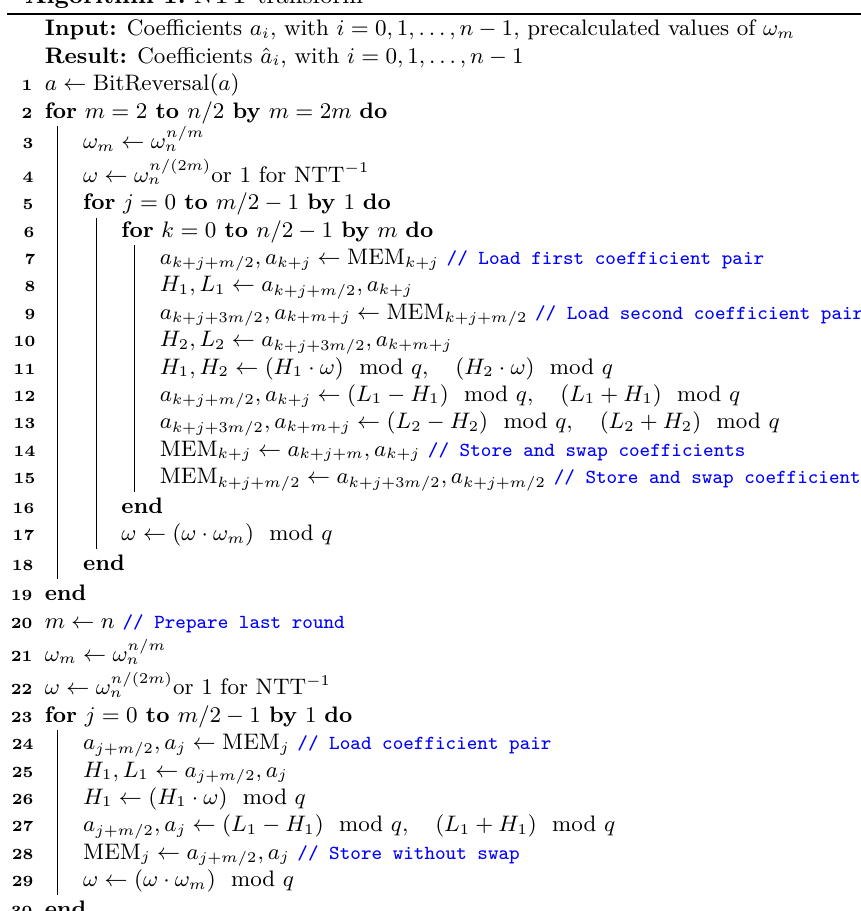
Algorithm 1: NTT